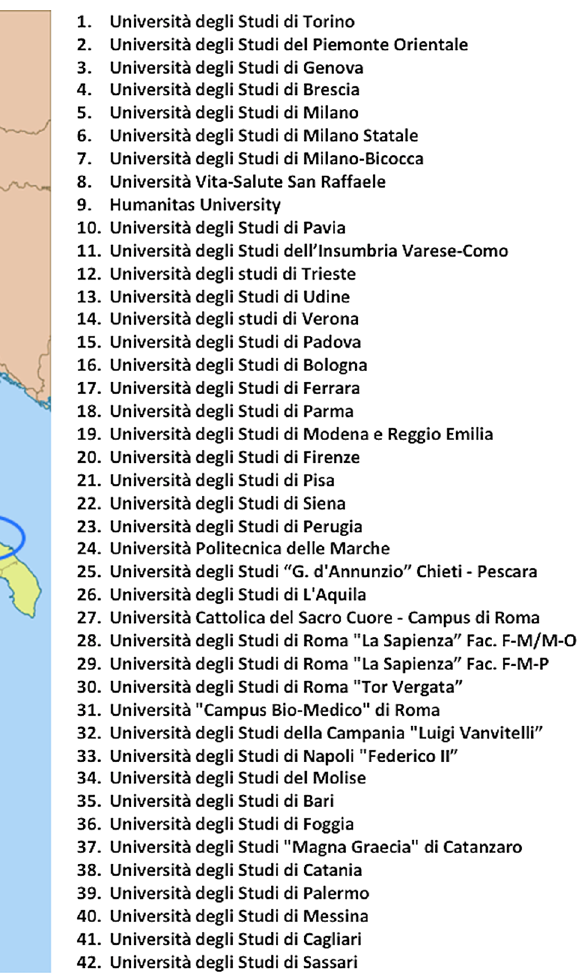
Fig. 1 Schematic distribution of participating sites in the Italian national